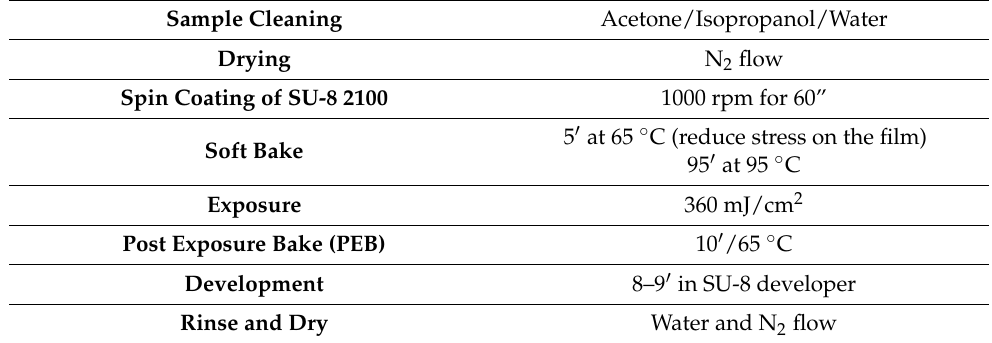
Figure 1. Schematic representation of a bilayer photolithography process ( a ); fabricated SAW device ( b ) and relative elec- tronic microscope images at 10× ( c ), 20× ( d ) and 100× ( e ); schematic representation of SU-8 microchannel photolithography ( f ), fabricated device ( g ) and its microscope images at 4× and 10× ( h ). Table 2. Microfabrication process of ~300 μ m thick microfluidic channel flow process.